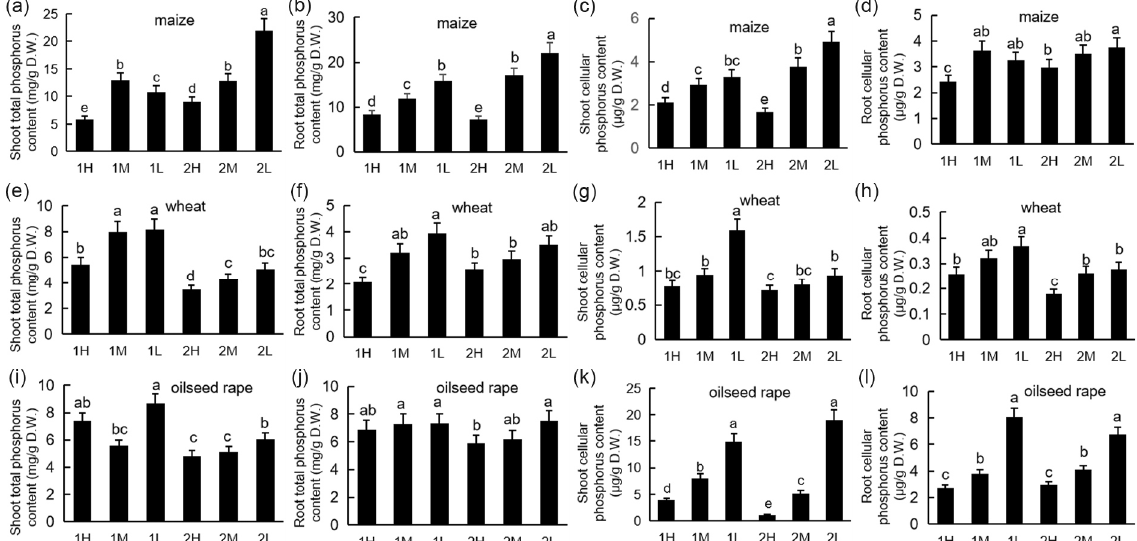
Figure 3. P levels of maize, wheat, and oilseed rape seedlings under different light conditions: 20-day-old seedlings were subjected to one week of relatively high-light treatment (1H), one week of medium-light treatment (1M), one week of relatively low-light treatment (1L), two weeks of relatively high-light treatment (2H), two weeks of medium-light treatment (2M), or two weeks of relatively low-light treatment (2L). D.W.: dry weight. Total phosphorus concentrations of maize ( a ), wheat ( e ), and oilseed rape ( i ) shoots and maize ( b ), wheat ( f ), and oilseed rape ( j ) roots. Cellular Pi levels of maize ( c ), wheat ( g ), and oilseed rape ( k ) shoots and maize ( d ), wheat ( h ), and oilseed rape ( l ) roots. Bars represent standard deviations of 3 independent replicates (3 seedlings per replicate). Values followed by different letters are significantly different at p < 0.05 according to Duncan’s multiple range test.